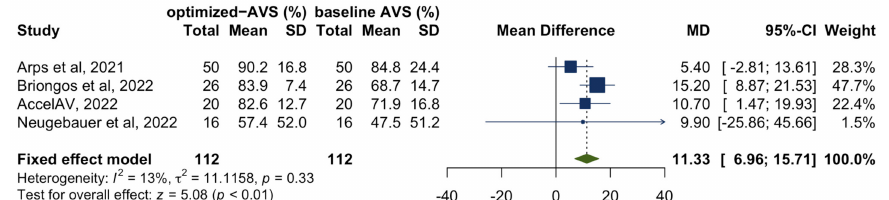
Figure 3. Forest plot of the change in atrioventricular synchrony after programming optimization. Abbreviation: AVS = atrioventricular synchrony [8,10,14,15].